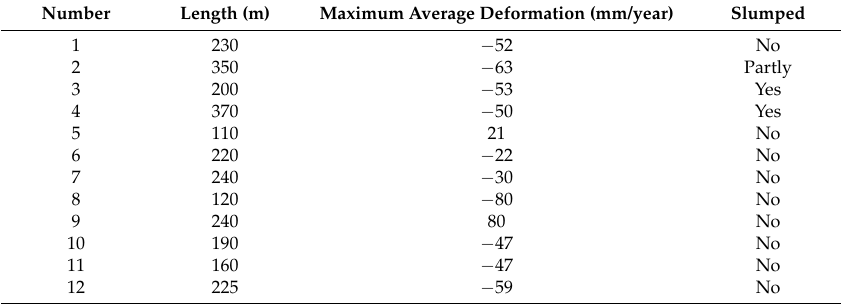
Table 1. Location, length, and maximum deformation rate in the LOS direction of all creep bodies (Notice that the negative values imply movements toward the sensor and the positive values are away from the sensor.)